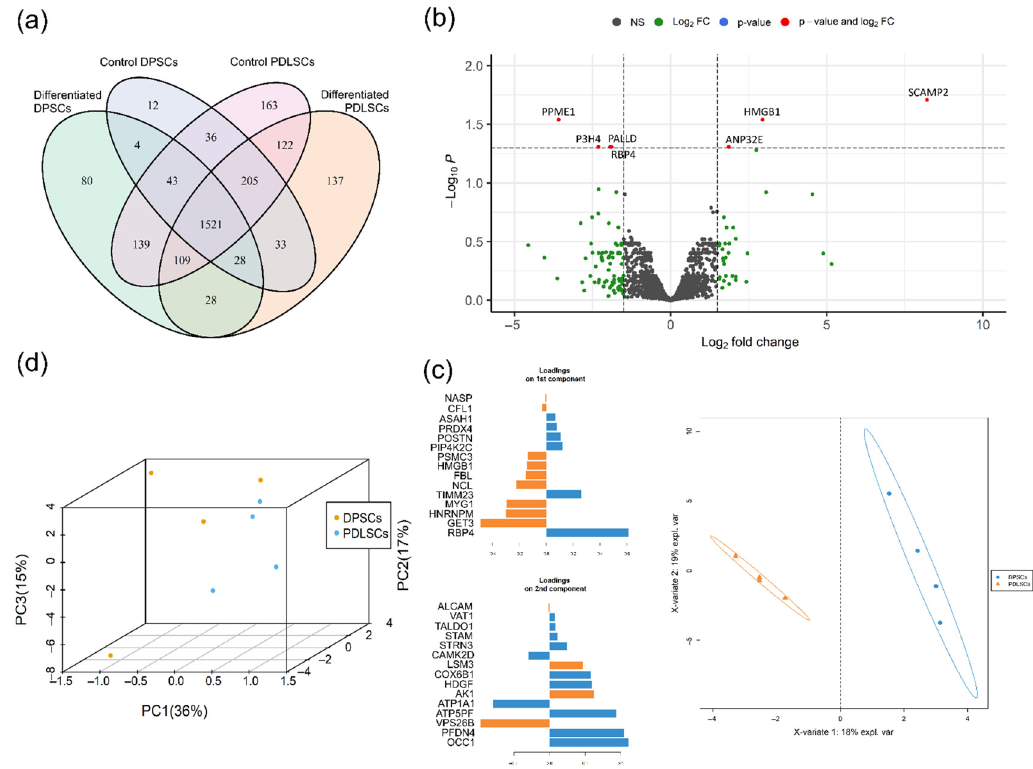
Figure 5. Comparison of proteomics profiles of PDLSC and DPSC during osteogenic differentiation. ( a ) Venn diagram representing proteins unique for biological groups compared by shotgun proteomics. ( b ) Volcano plot representing differentially expressed proteins between DPSC and PDLC. Log2Fold Change—level of change in expression-Log10P—logarithm of p –value. Dotted lines cut off transcripts with p -value < 0.05 and Log2Fold Change > |1.5|. ( c ) Ordination of DPSC and PDLSC by principal component analysis. Blue dots—DPSC, orange dots—PDLSC. ( d ) Classification of DPSC and PDLSC by sparse Partial Least Squares Discriminant Analysis (sPLS–DA). Blue circles—DPSC, orange triangles—PDLSC. Loadings on the 1st and 2nd component represent 15 proteins, which contribute the most to the respective components, the color represent in which of the group the mean of the protein is maximal.